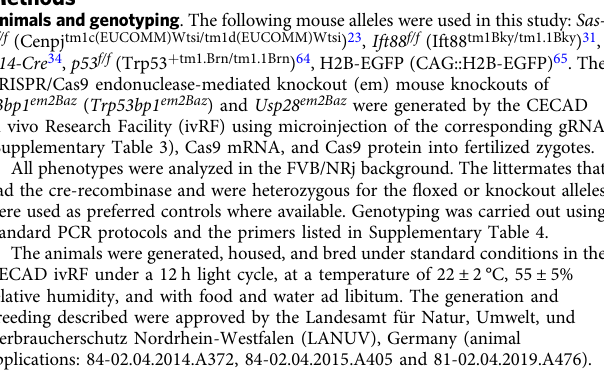
(Supplementary Table 3), Cas9 mRNA, and Cas9 protein into fertilized zygotes. All phenotypes were analyzed in the FVB/NRj background. The littermates that had the cre-recombinase and were heterozygous for the fl oxed or knockout alleles were used as preferred controls where available. Genotyping was carried out using standard PCR protocols and the primers listed in Supplementary Table 4. The animals were generated, housed, and bred under standard conditions in